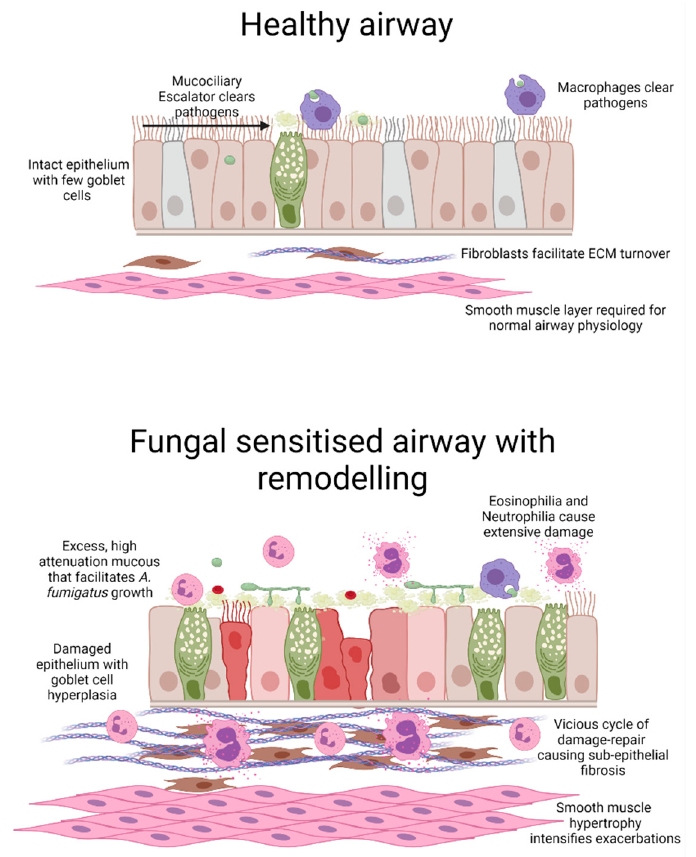
Figure 1. Schematic representation of A. fumigatus -induced airway wall remodelling. Compared with the healthy airway, a fungal-sensitised asthmatic airway displays extensive inflammation and remodelling. Airway remodelling includes areas of damaged epithelium coupled with goblet cell hyperplasia and excess mucus secretion which likely facilitates fungal growth. Coupled with increased inflammation, activation of fibroblasts and expansion of smooth muscle cells results in airway narrowing with possible luminal obstruction. Image generated in BioRender.